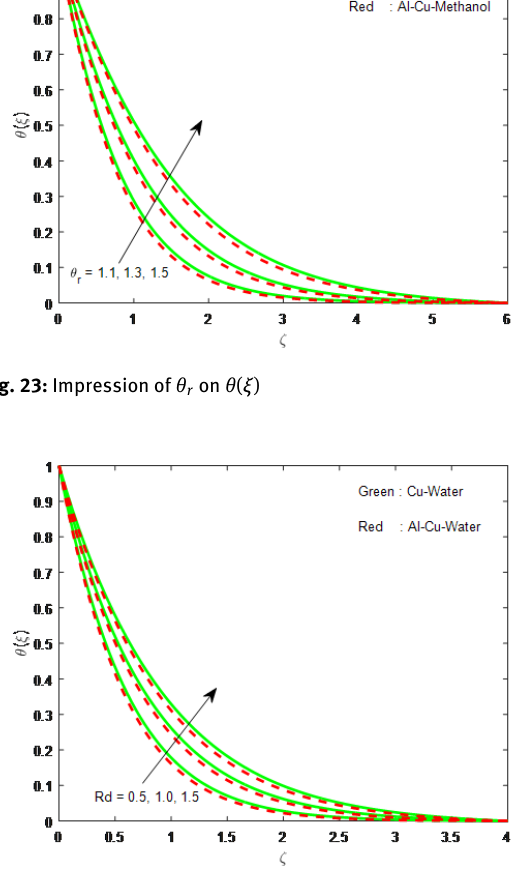
that secondary velocity ( g (cid:48) ( ξ )) is well affected by Λ .